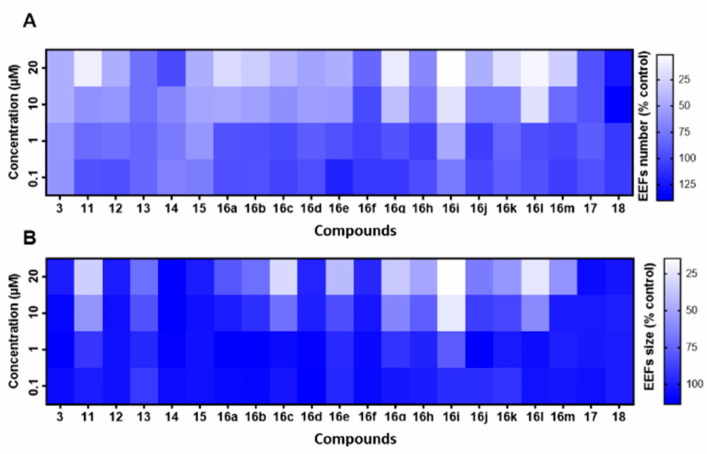
Figure 5. Normalized dose–response heatmap in PHH- Pb -GFP regarding EEF number ( A ) and EEF size ( B ) at 0.1, 1, 10, or 20 µ M of the indicated compounds. These results were obtained from four technical